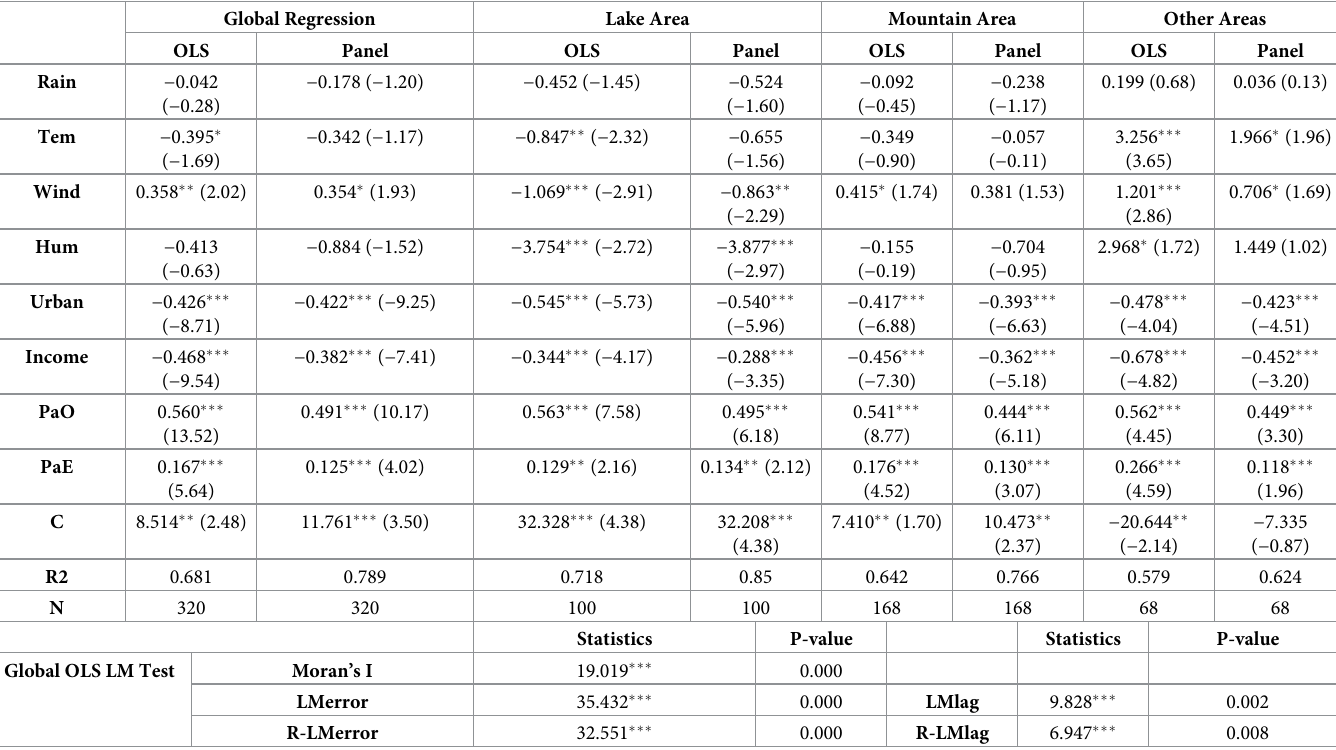
Table 3. Mixed OLS regression and panel regression